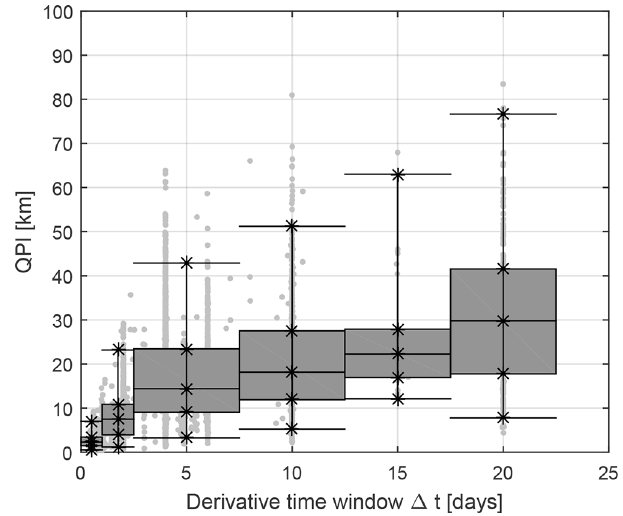
Figure 4. Scatter plot of the quasi-planktonic index (QPI) as a func- tion of the derivative time window (time spanned by three profiles) for all float profiles (dots) along with box and whisker plots indi- cating the 2.5, 25, 50, 75, and 97.5 percentiles. Bins are [0, 1)d, [1, 2.5)d, and then span 5d after